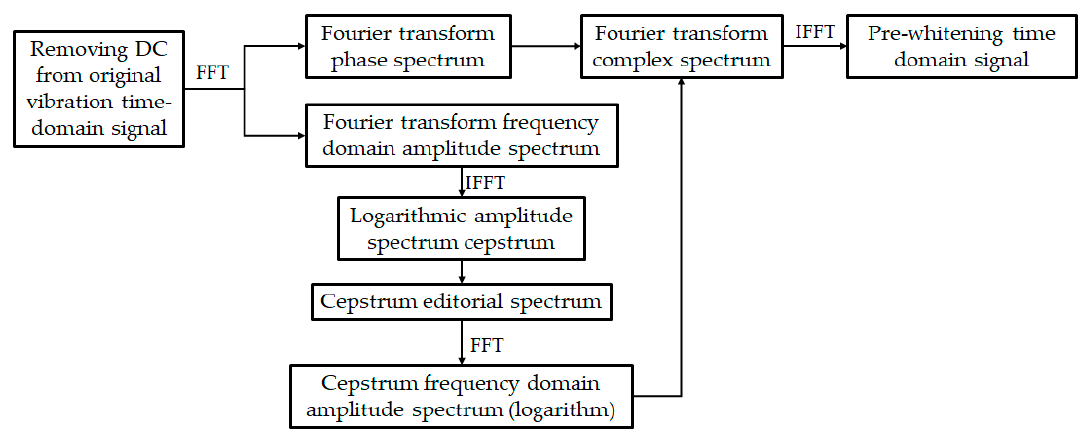
Figure 3. Flow chart of the Cepstrum Editing Pre-Whitening (CPW) algorithm.